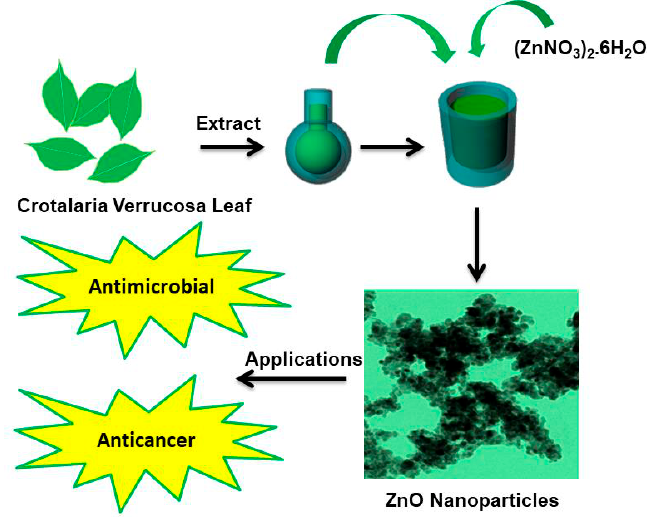
Figure 1. Schematic illustration of the biological synthesis of ZnO NPs using Crotalaria verrucosa leaf extract and its applications.